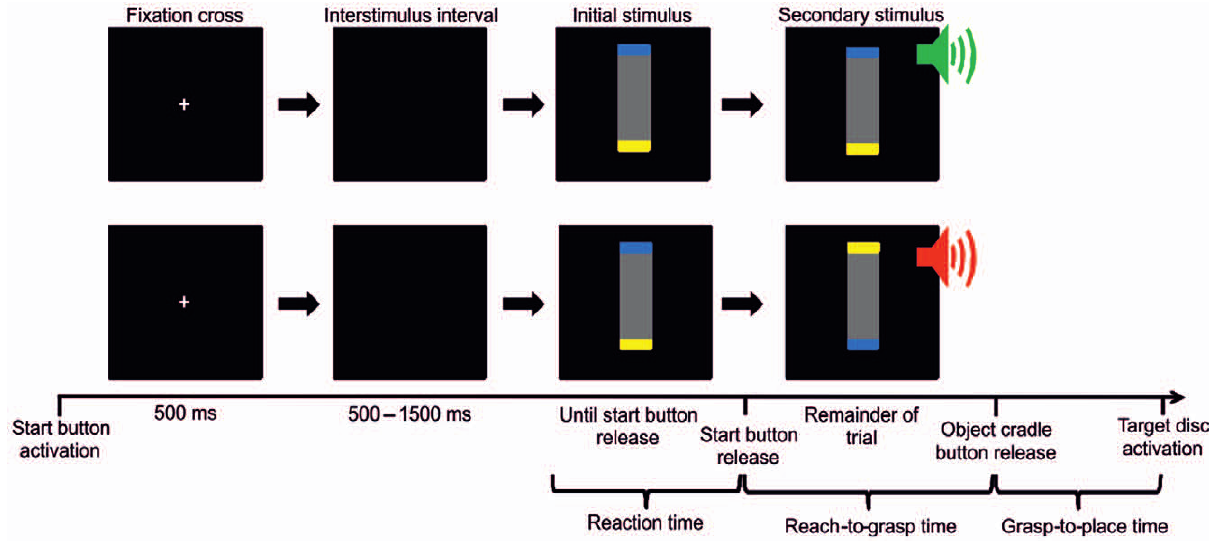
Figure 2. The temporal sequence of the experimental paradigm. At the beginning of each trial, a fixation cross was presented (500 ms). After a randomized interstimulus interval (500–1500 ms), the initial stimulus appeared and indicated which end of the object was to be placed on the target (left end-down, right end-down). After the participant lifted their hand from the start button, a secondary stimulus was triggered. (A) During non-perturbed trials, the visual stimulus was identical to the initial stimulus, and was paired with an auditory cue indicating that the intended object end-orientation had not changed. (B) During perturbed trials, the secondary visual stimulus differed from the initial stimulus, and was paired with an auditory cue indicating that the intended object end-orientation had